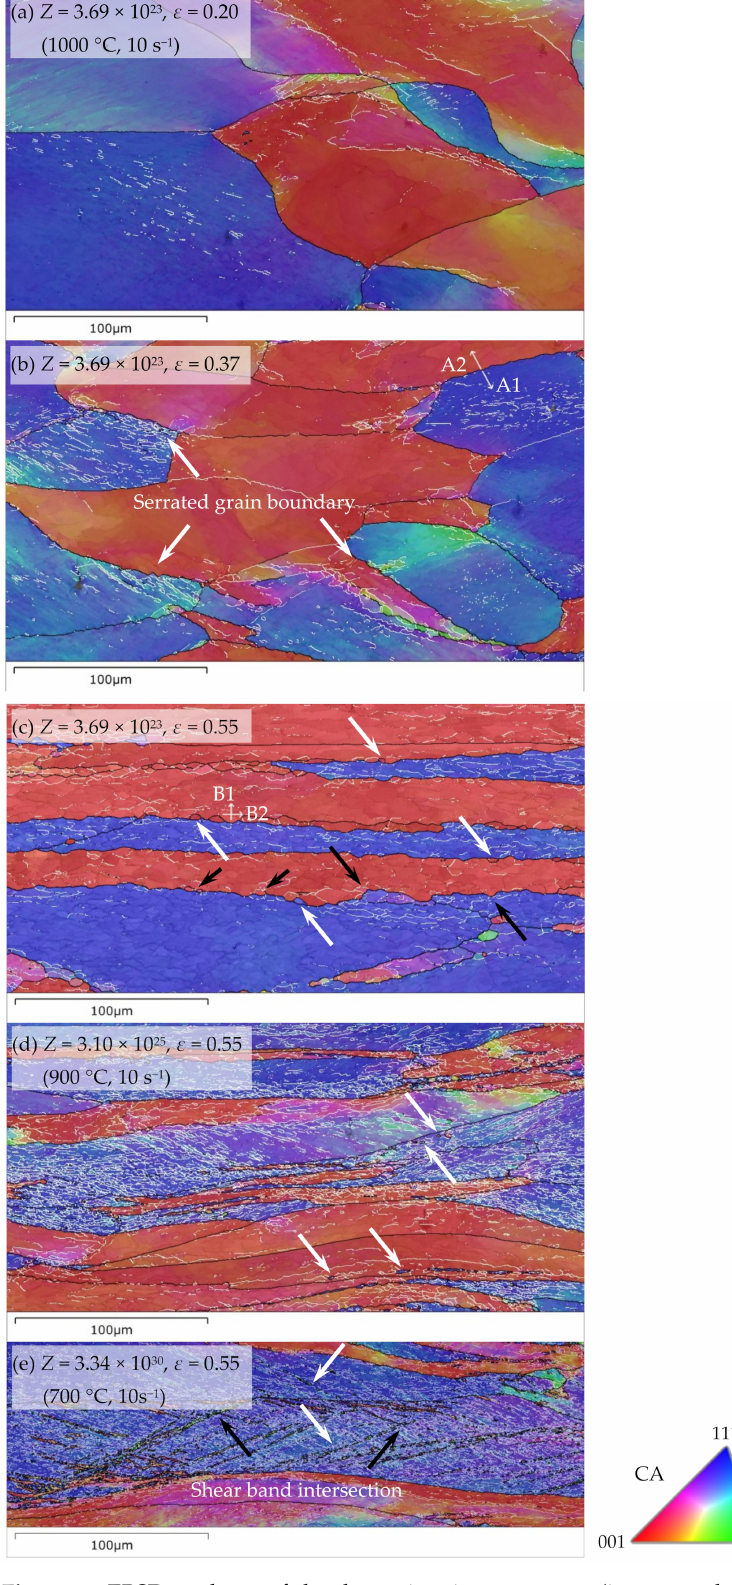
Figure 7. EBSD analyses of the dynamic microstructures (inverse pole figure maps for the CA (compression axis) direction) after deformation at different deformation conditions. (White and black lines denote low-angle grain boundary (LAGBs) (2–15 ◦ ) and high-angle grain boundary (HAGBs) (greater than 15 ◦ ),